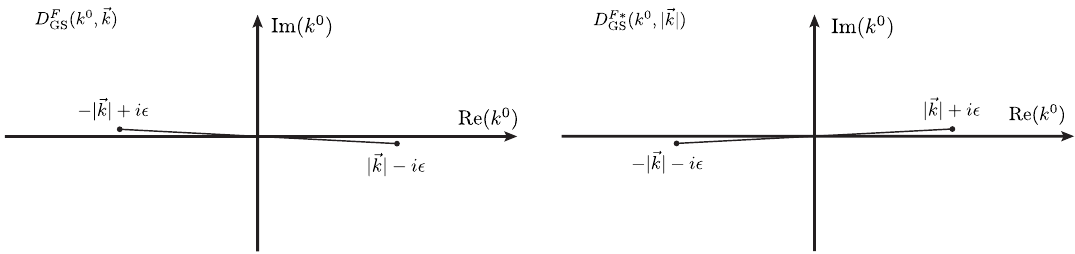
Figure 3 . Branch points and branch cuts of the D F ( (cid:3) ) complex conjugation of D F branch cut are di(cid:11)erent, so equation D F ( (cid:3) )